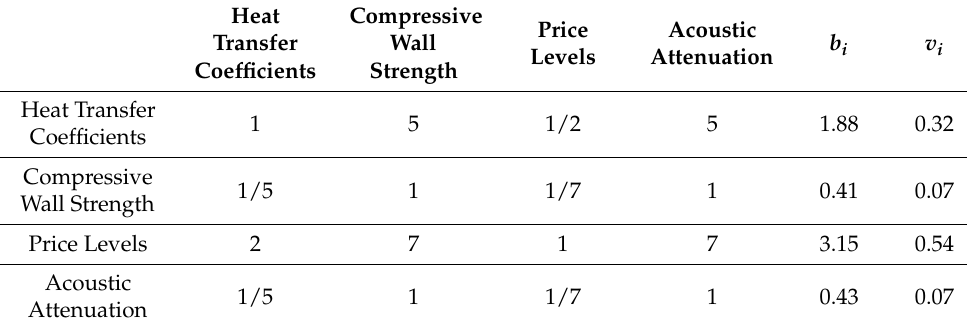
Table 4. The Saaty matrix and values of b i and v i .